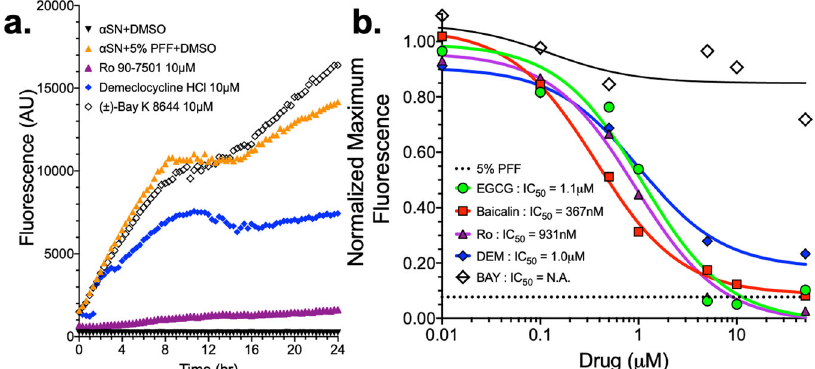
Fig. 11 Seeded Thio fl avin-T aggregation assay shows direct protein interaction for subset of hit compounds. Seeded ThT aggregation assay was performed using 15 μ M monomeric α SN doped with 5% (0.75 μ M sonicated α SN pre-formed fi bril (PFF) seeds) in a 384-well plate under slow agitation (300 RPM) at 37 °C. a Control samples for the aggregation include PBS (black), α SN monomer (brown), 5% α SN PFF (red), and the 15 μ M monomer + 5% PFF mixture (orange). Dose-response curves were made with a titration of compounds. Some hit compounds had little to no effect on aggregation, even at 50 μ M (e.g., SB206553). In contrast, RO and DEM both show potent effects relative to Baicalin and EGCG controls. BAY does have some response, but it lags behind other hit compounds. b Normalizing the initial peak in ThT data allows us to estimate an IC 50 for each hit. Control compounds EGCG and Baicalin show 1.1 μ M and 387 nM potency, whereas RO and DEM have IC50 of 931 nM and 1.0 μ M. Although there is a small trend with BAY, the data cannot be fi t to resolve an IC 50